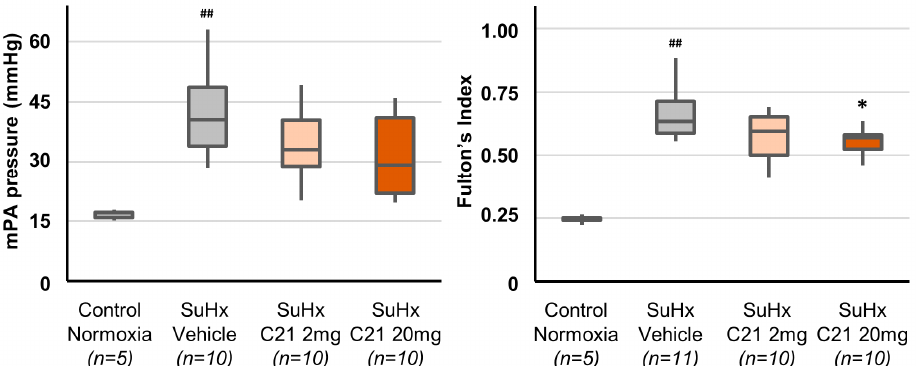
Figure 2. Mean pulmonary artery (mPA) pressure and right ventricular hypertrophy (Fulton’s Index) on day 56. The box and whiskers represent the median, interquartile range, minimum and maximum values. ## p < 0.01 compared with normoxic animals (Mann–Whitney U-test). * p < 0.05 compared with SuHx Vehicle animals (Kruskal–Wallis test).